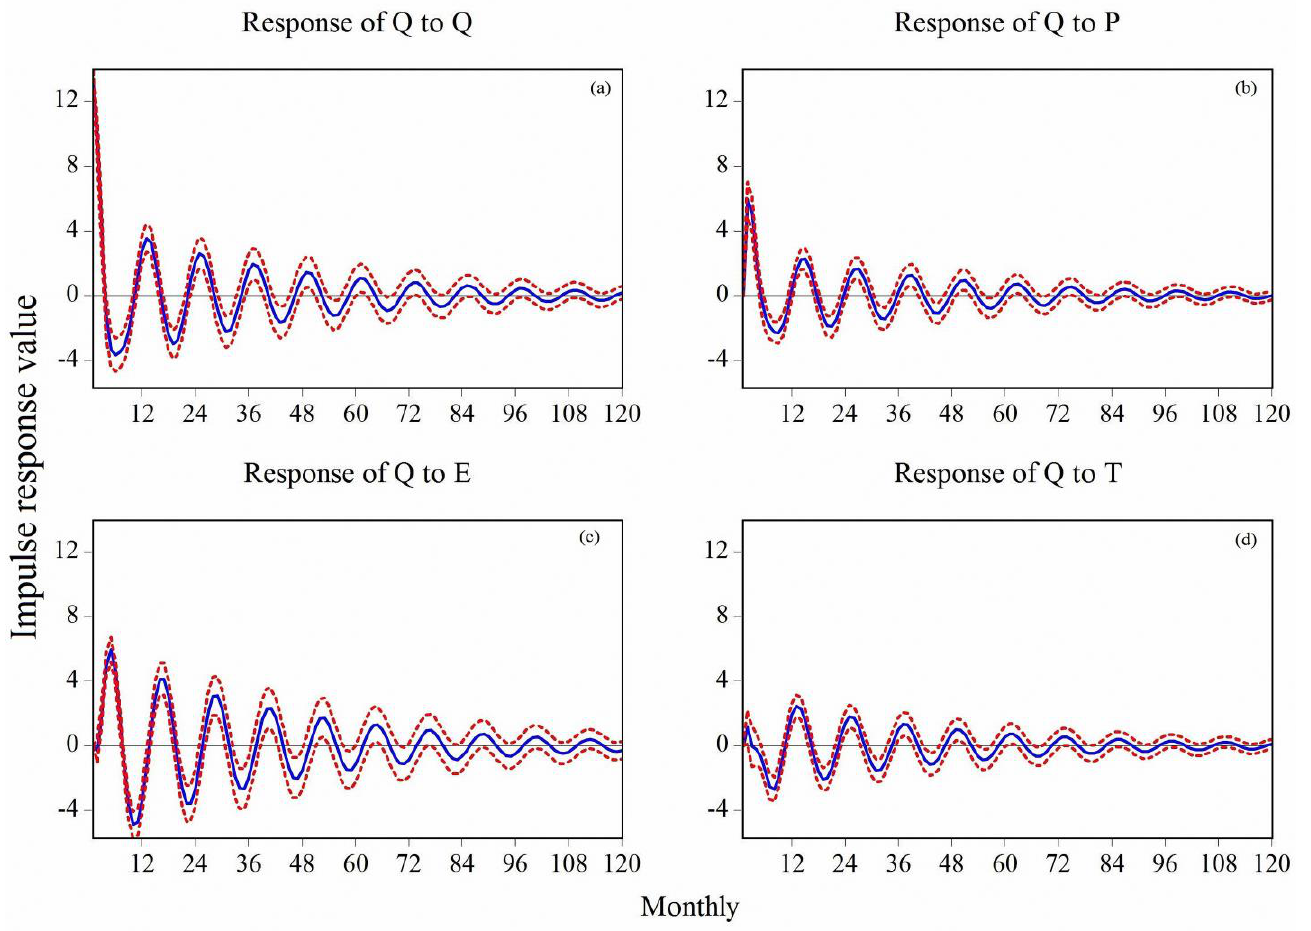
Figure 9. Impulse response curves of runoff.